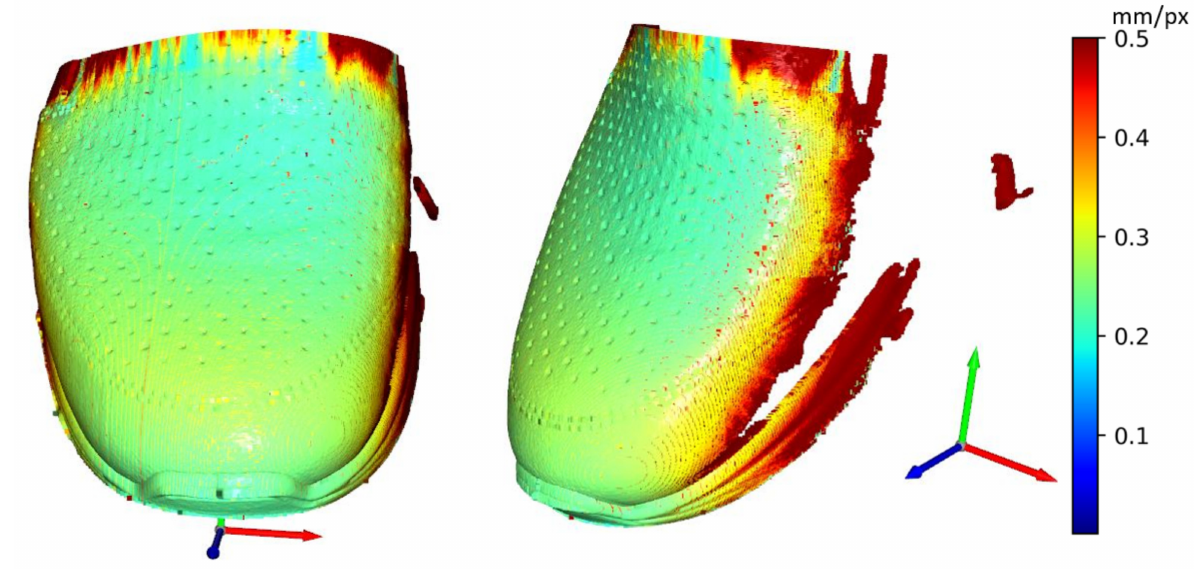
Figure 18. Displaying of resolution (R) (SCAN 20).